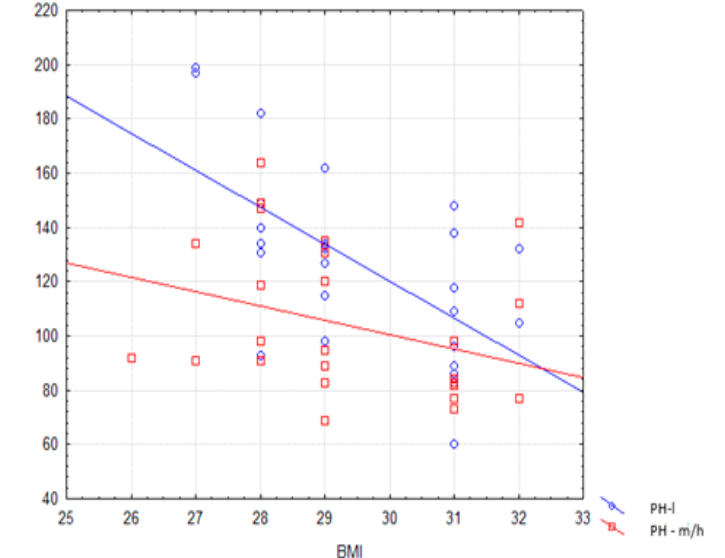
Figure 1. Diagram of dispersion minimal paO 2 during tracheal intubation and mechanical ventilation (PaO 2 min. mechanical ventilation) relative to Body Mass Index (BMI) for two categories of echocardiographic PH probability.